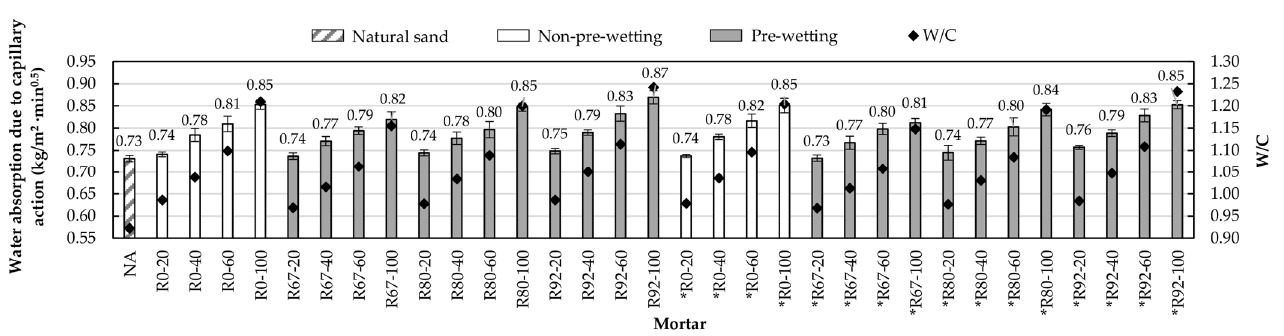
Figure 14. Water absorption due capillary action values and water/cement ratio. The relationship between water absorption due to capillary action and water/cement ratio is shown in Figure 15.